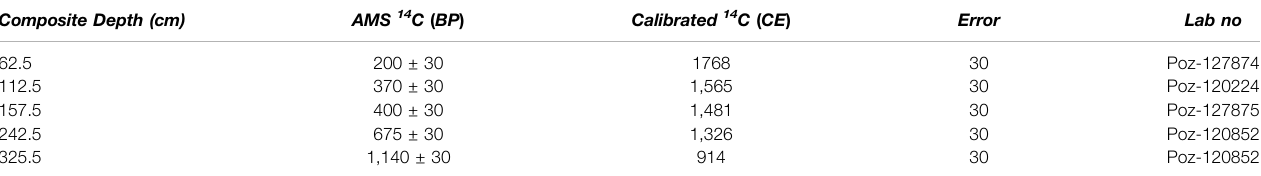
TABLE 1 | Radiocarbon ages for the GBW core based on OxCal calibration (Reimer et al., 2020). Composite Depth (cm)